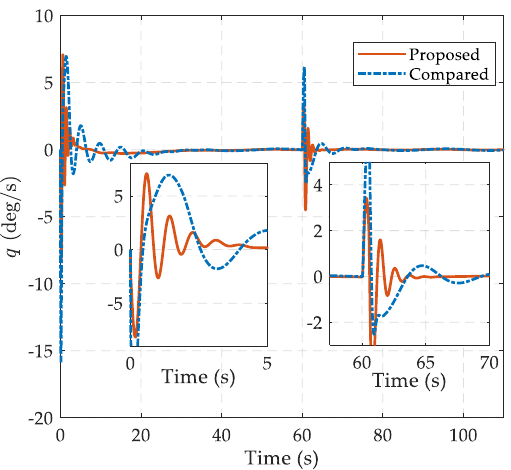
Figure 5. The curves of angle of attack  in the comparative simulations.